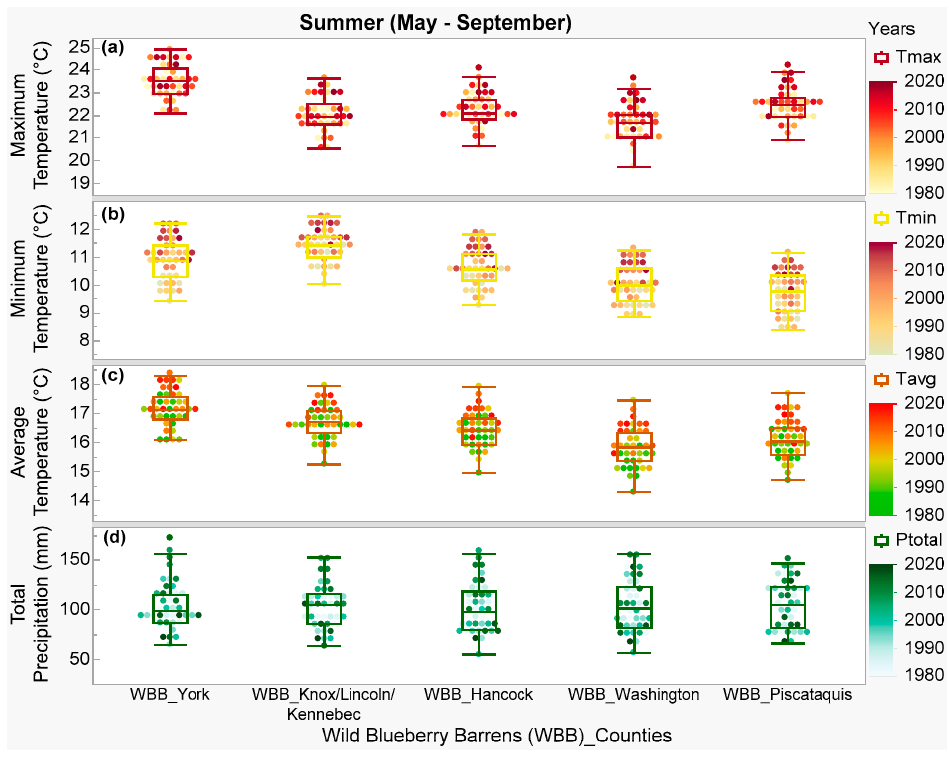
Figure 4. Comparison of historical (1980 to 2020) summer climate parameters: ( a ) maximum temperature, ( b ) minimum temperature, ( c ) average temperature, and ( d ) total precipitation among the studied wild blueberry barrens (WBBs) in different counties from north-central (Piscataquis) and north-east (Washington, Hancock) to south-west (Knox, Lincoln, Kennebec, York) of Maine as shown in Figure 1.